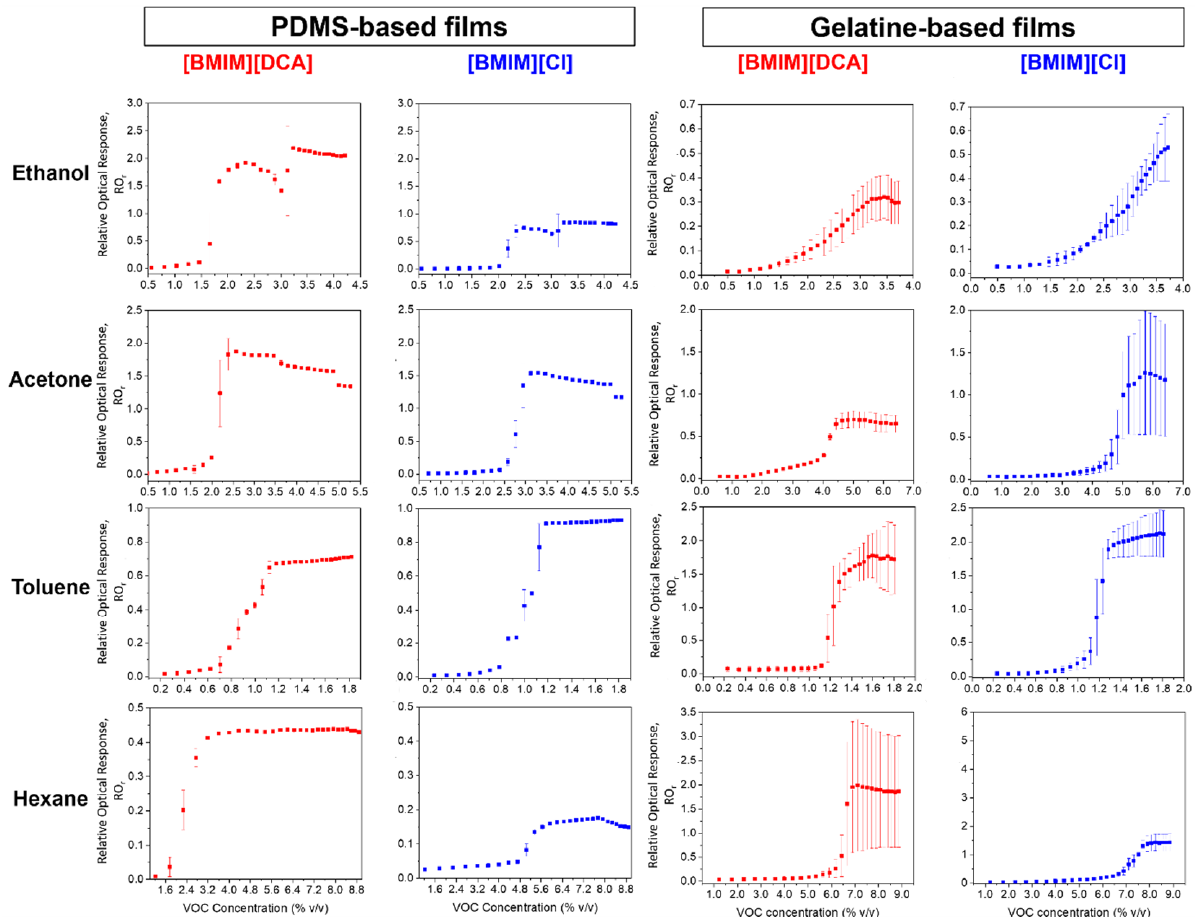
Figure 7. Variation of the relative optical response of hybrid films with the increase in concentration of ethanol, acetone, toluene and hexane, dissolved in humid (50% RH) nitrogen ( n = 5 exposure cycles to VOC for each concentration).